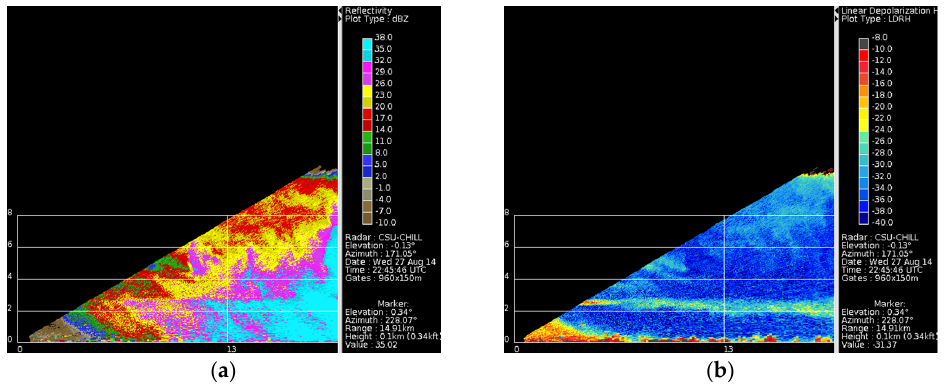
Figure 15. Easton site (12.92 km range) with ~30 dBZ rain: CSU-CHILL Radar measurements of ( a ) Z e and ( b ) LDR. LDR looks reasonable down to near-surface elevations. It appeared that reasonable LDR can be obtained down to lower reflectivity levels at the Easton site versus the Nesse site (Figure 14).